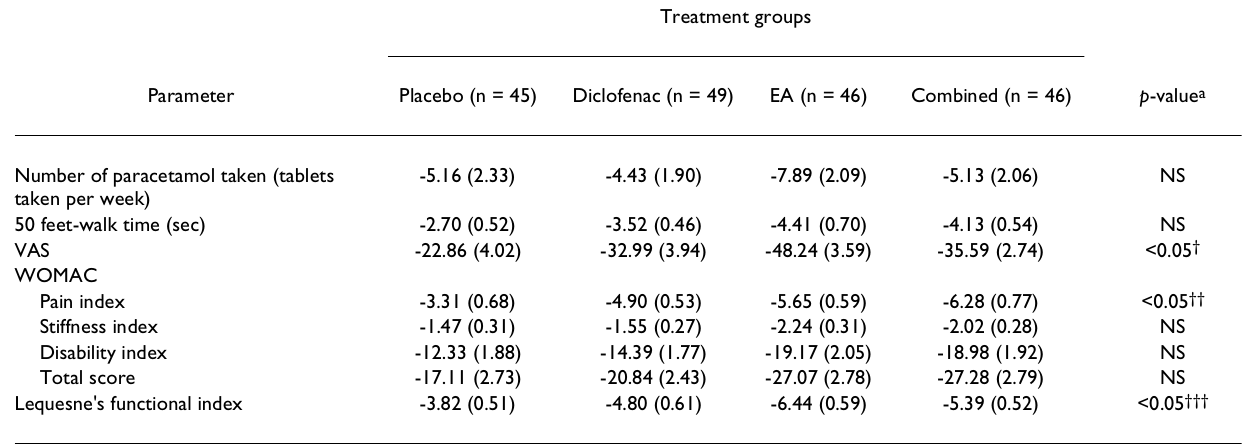
Table 4: Change in outcome parameters after 4 weeks of treatment * .